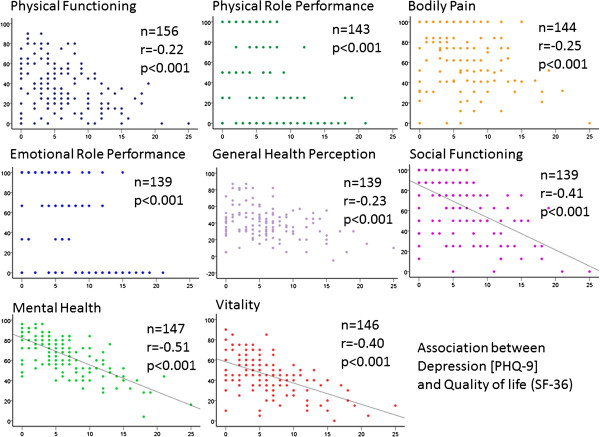
Correlation between the subscales of quality of life (SF-36; y-axis) and depression disorder (PHQ-9, x-axis). There was a significant correlation between the SF-36 subscales and depression score (p < 0.001 in all subscales). The highest correlation could be detected in the subscales vitality (r = −0.40) and mental health (r = −0.51). A linear regression line is only shown in the subscales social functioning, vitality and health (r-value >0.40), as only these showed evidence for a linear correlation.